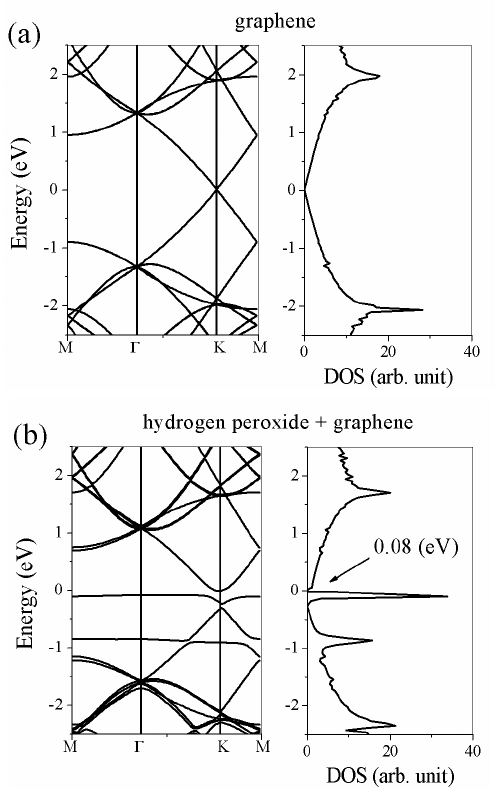
Fig. 3. Electronic band structures and DOS of defect free graphene (a) without and (b) with one hydrogen peroxide per supercell.